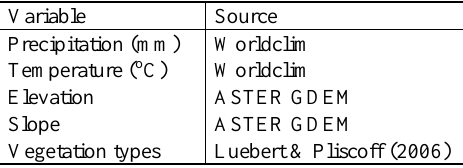
Table 1. Ancillary